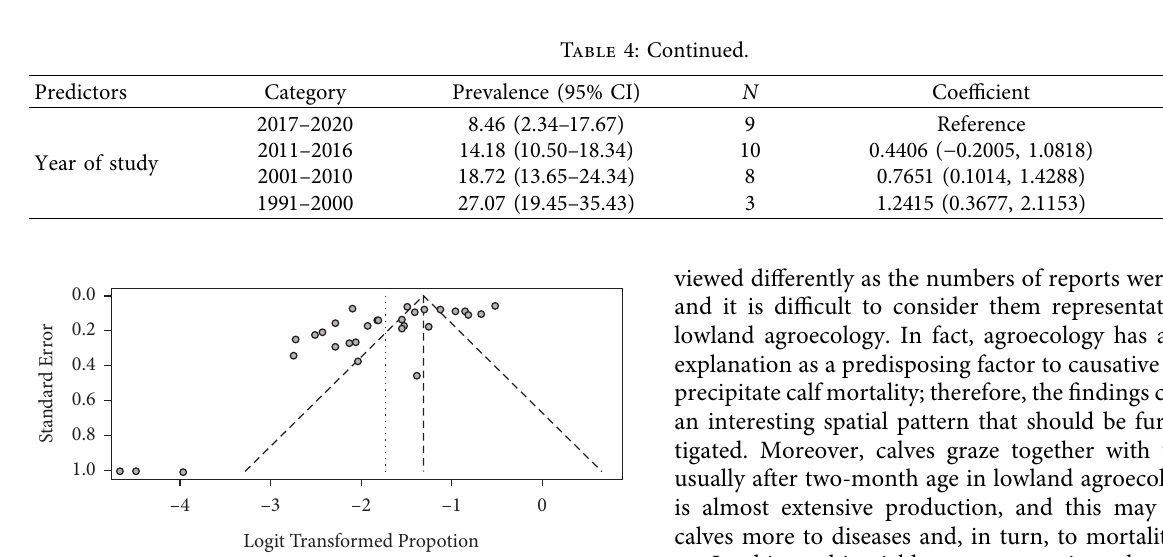
Figure 4: Funnel plots of the standard error by transformed prevalence